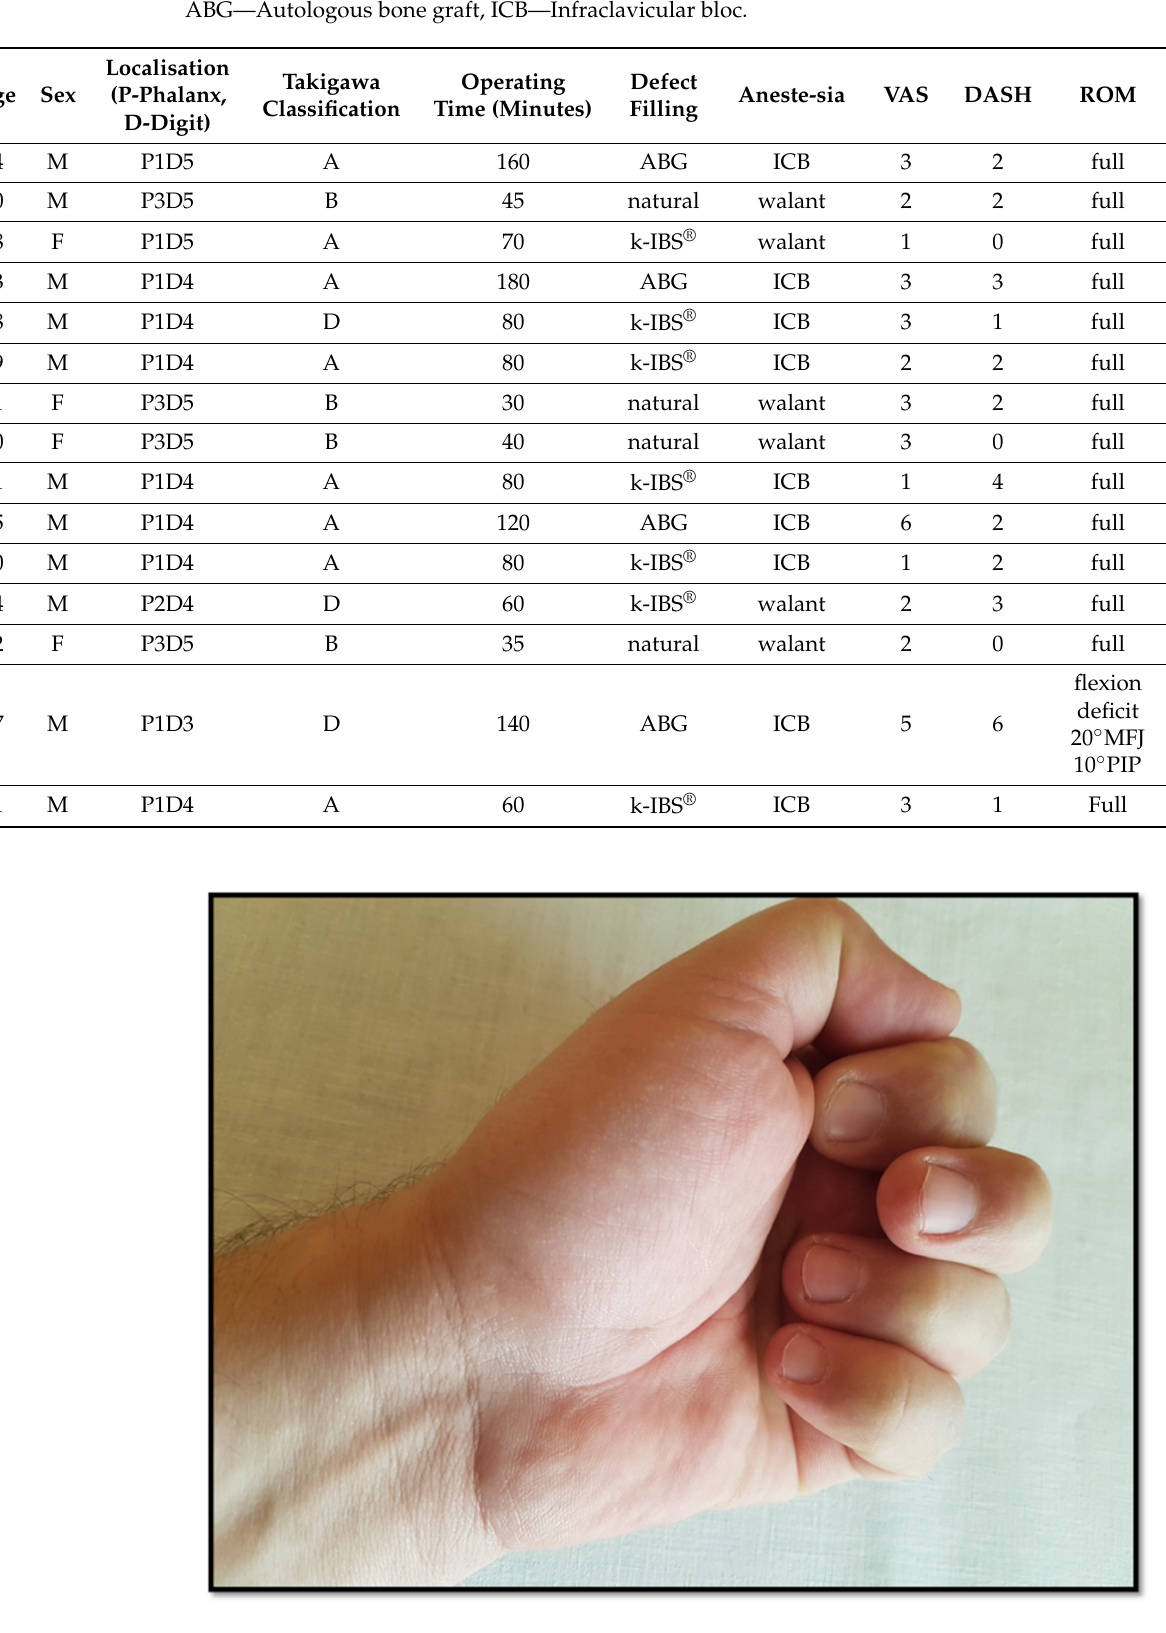
Figure 5. Flexion deficit in the MFJ and PIPJ of the 3rd